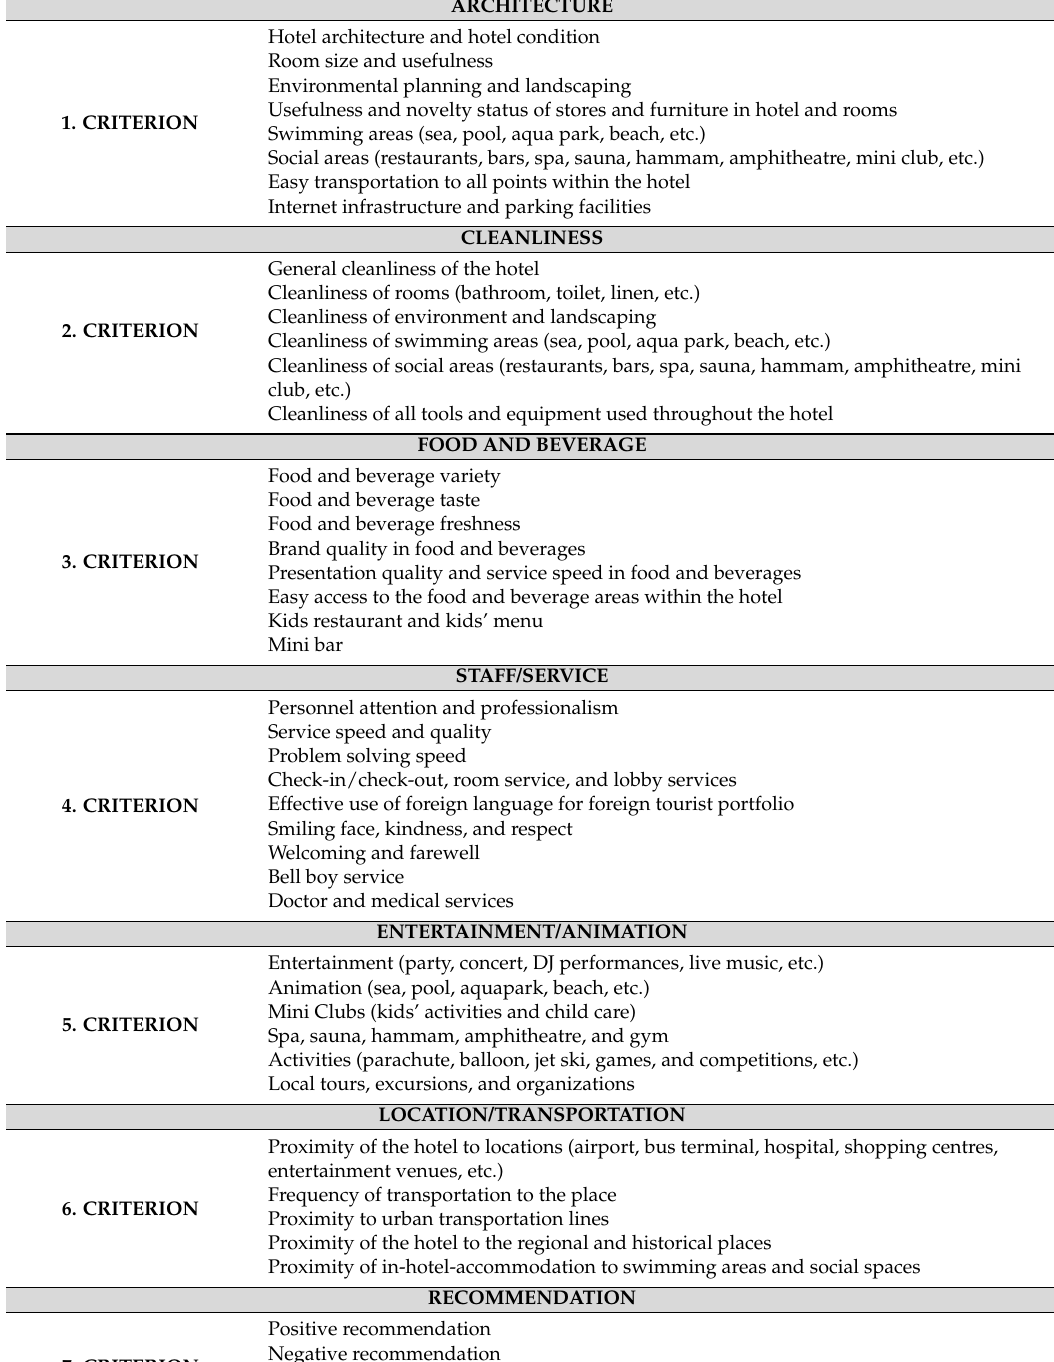
Table 1. Determined criteria and